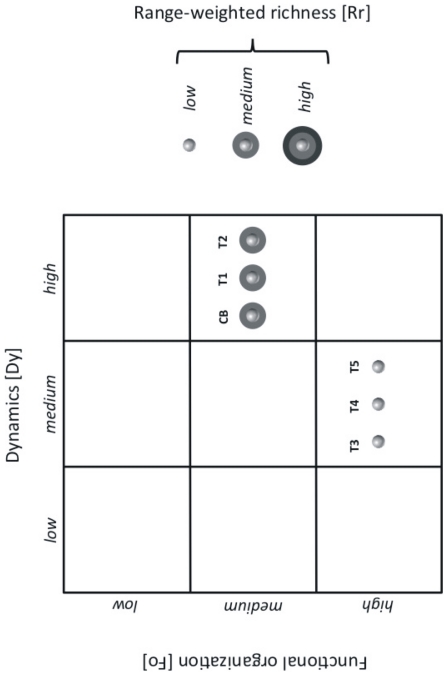
Schematic representation of DGGE results.The positioning of each sphere in a plot quadrate refers to a different ecological context and relative adaptation of the microbial community to the respective environmental conditions. CB control biofilm; T1–T5 biofilm exposed to increasing triclosan concentrations.